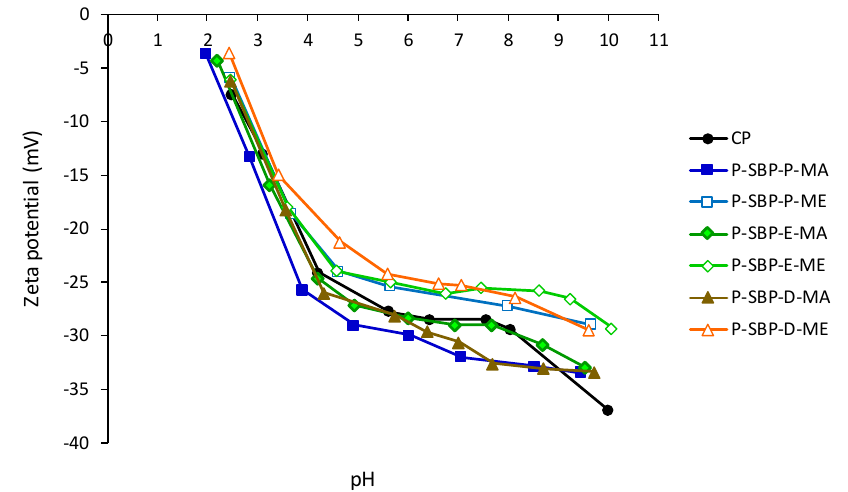
Figure 4. Zeta potential ( ζ ) curves of pectin. CP: citrus pectin. P-SBP-P-AM: pectin from sugar beet pulp pressed, acid method; P-SBP-P-EM: pectin from sugar beet pulp pressed, enzymatic method; P-SBP-E-AM: pectin from sugar beet pulp ensiled, acid method; P-SBP-E-EM: pectin from sugar beet pulp ensiled, enzymatic method; P-SBP-D-AM: pectin from sugar beet pulp dried, acid method; P-SBP-D-EM: pectin from sugar beet pulp dried, enzymatic